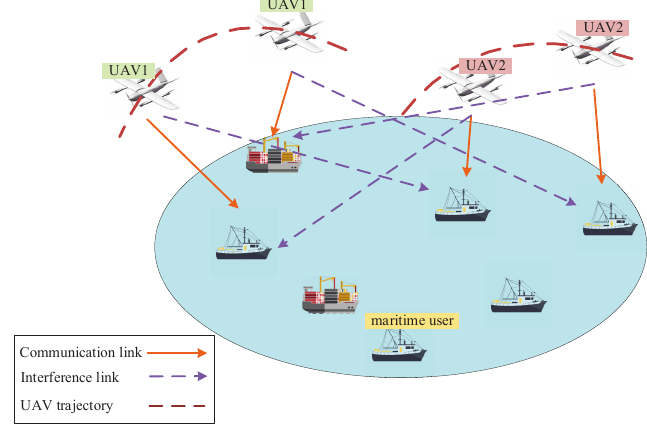
Figure 1. The multi-UAV-enabled maritime wireless